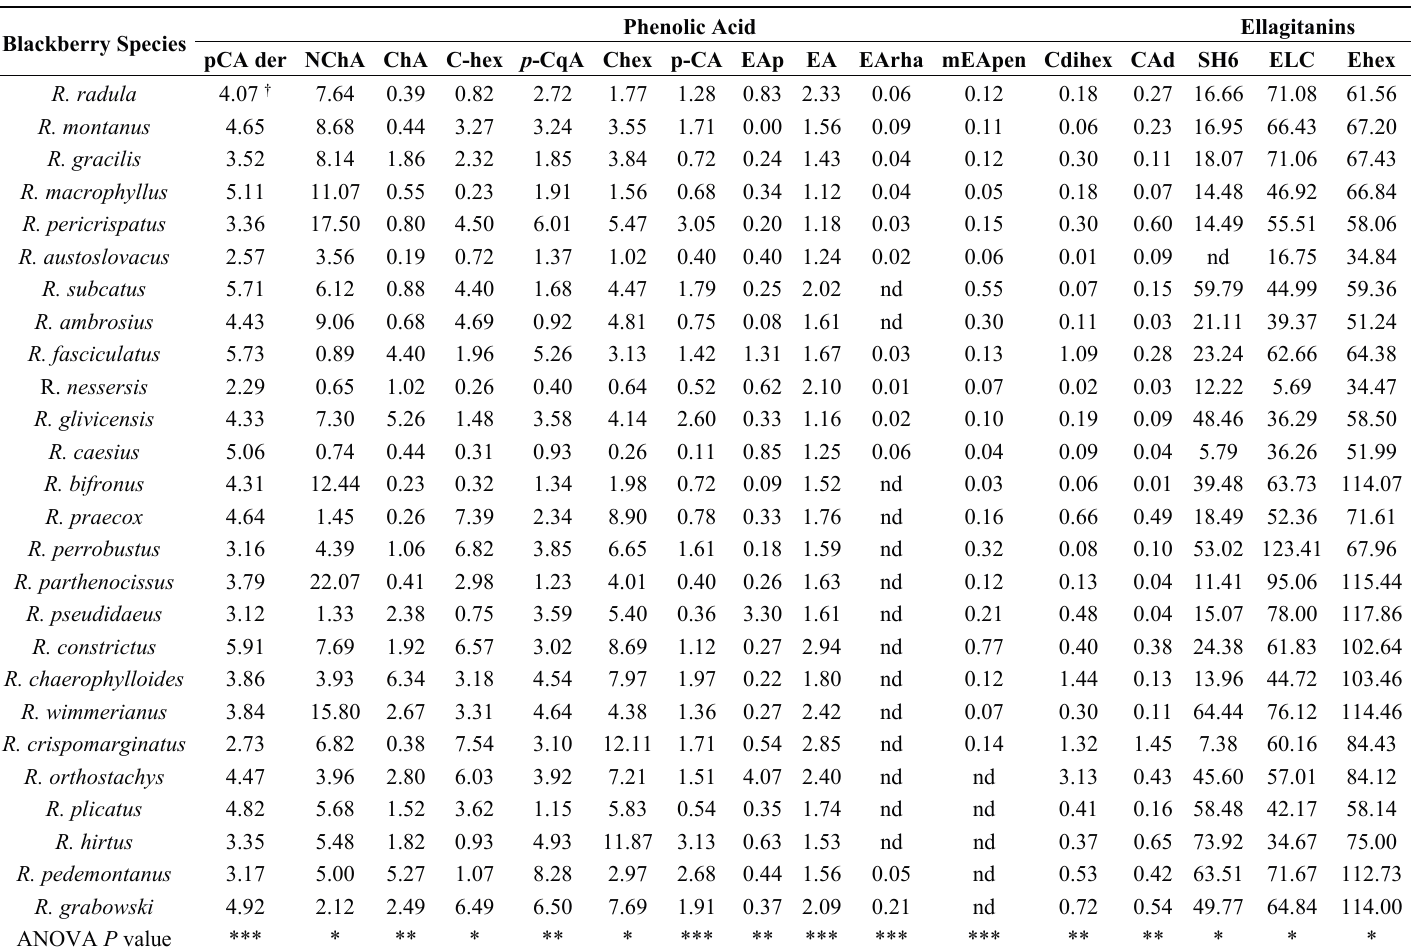
Table 2. Individual quantities (mean † , mg/g dm) of each phenolic acid and ellagitannin in different leaves of wild Rubus L. species. Blackberry